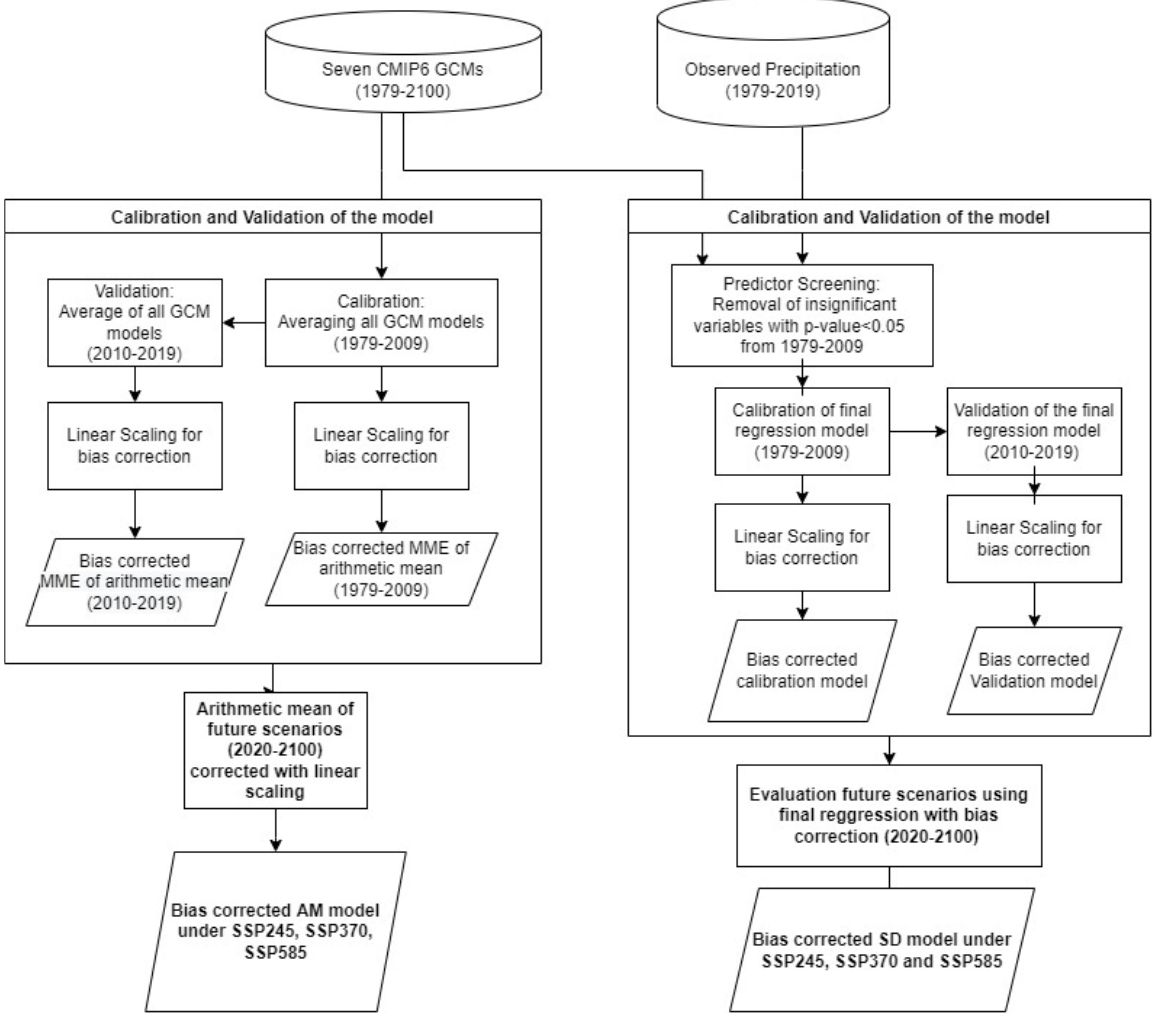
Figure 2. Schematic flowchart of the methodology.